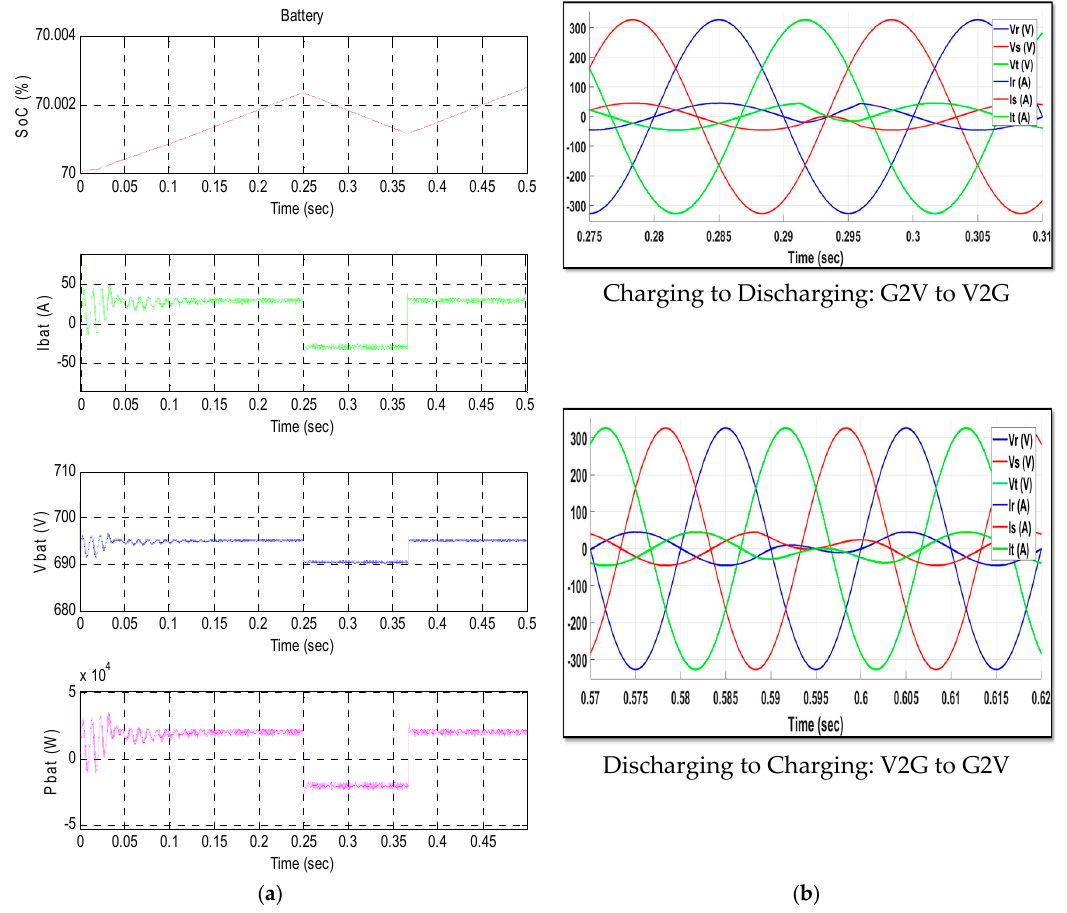
Figure 23. Transitions in the operation mode for Heavy-Duty Vehicles. ( a ) Battery Curves; ( b ) Grid Current and Voltage.